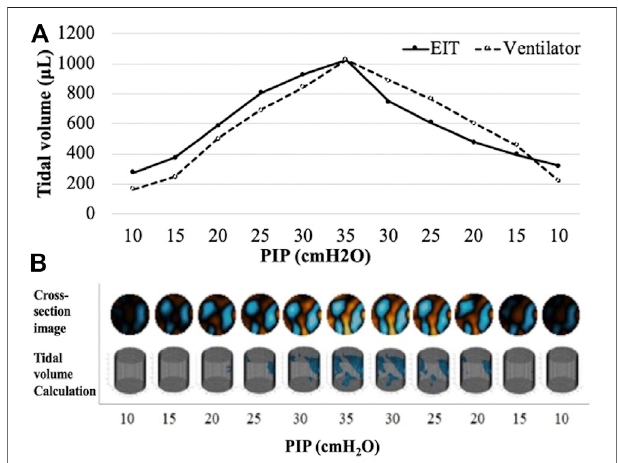
FIGURE 1 | An example of tidal volume measurement and EIT images in asubject frompretermtreated group (A) Pressure-volume curves ofventilator tidal volume and EIT tidal volume. (B) The reconstructed chest cross-section EIT according to PIP change. PIP, peak inspiratory pressure.